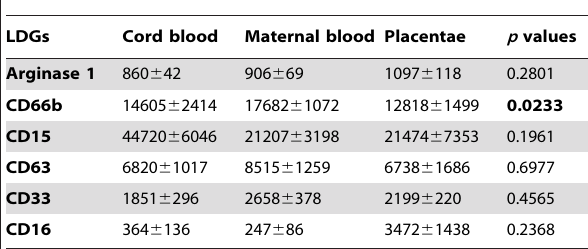
Table 3. Comparison of expression levels of arginase and phenotypic markers of LDGs in placentae, cord and maternal